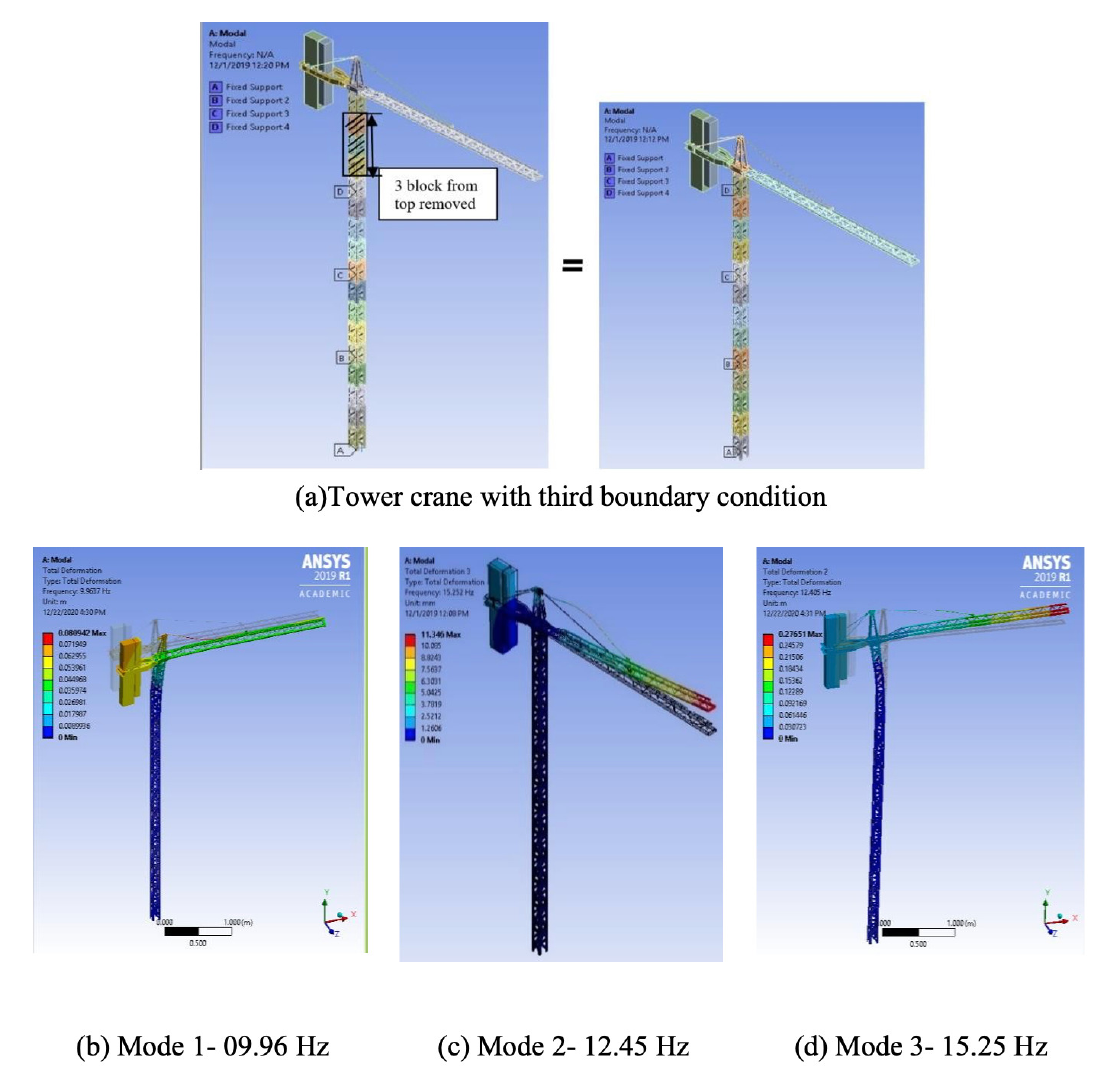
Figure 13. Modal parameters of the tower crane with four